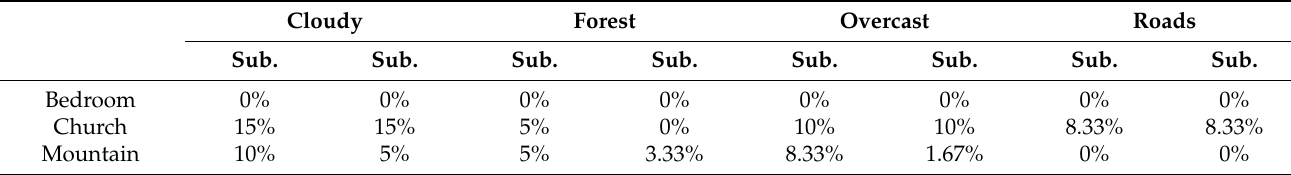
Table 5. Average accuracy when five attributes are selected from each image. Cloudy Forest Overcast Roads Sub. Sub. Sub. Sub. Sub. Sub. Sub. Sub. Mountain